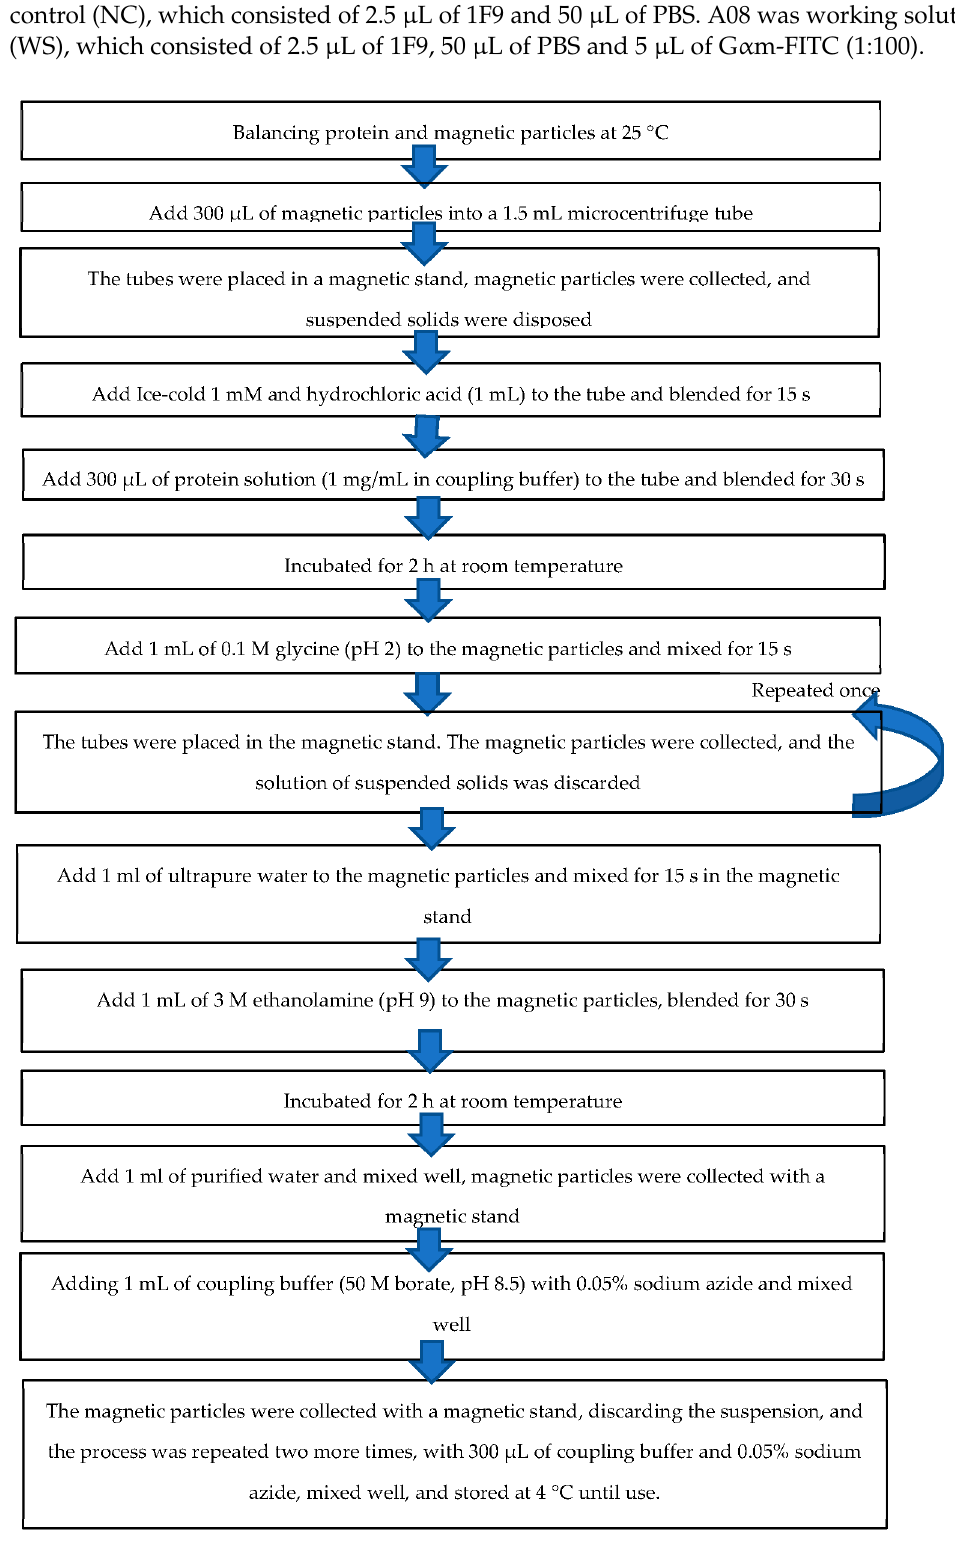
Figure 3. The procedure of preparation of monoclonal antibodies conjugated with magnetic